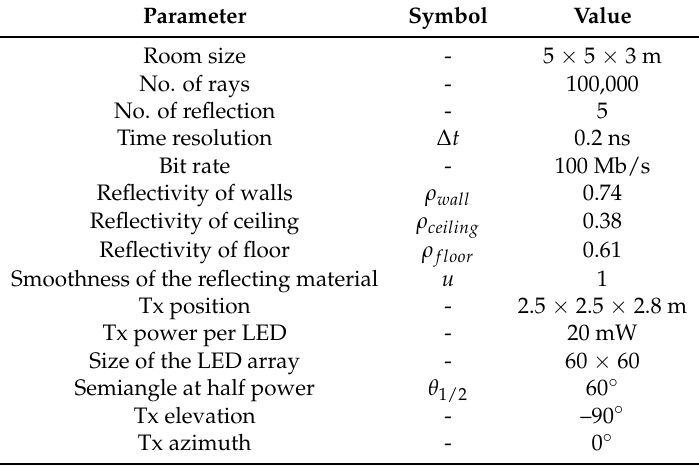
Table 1. Key System